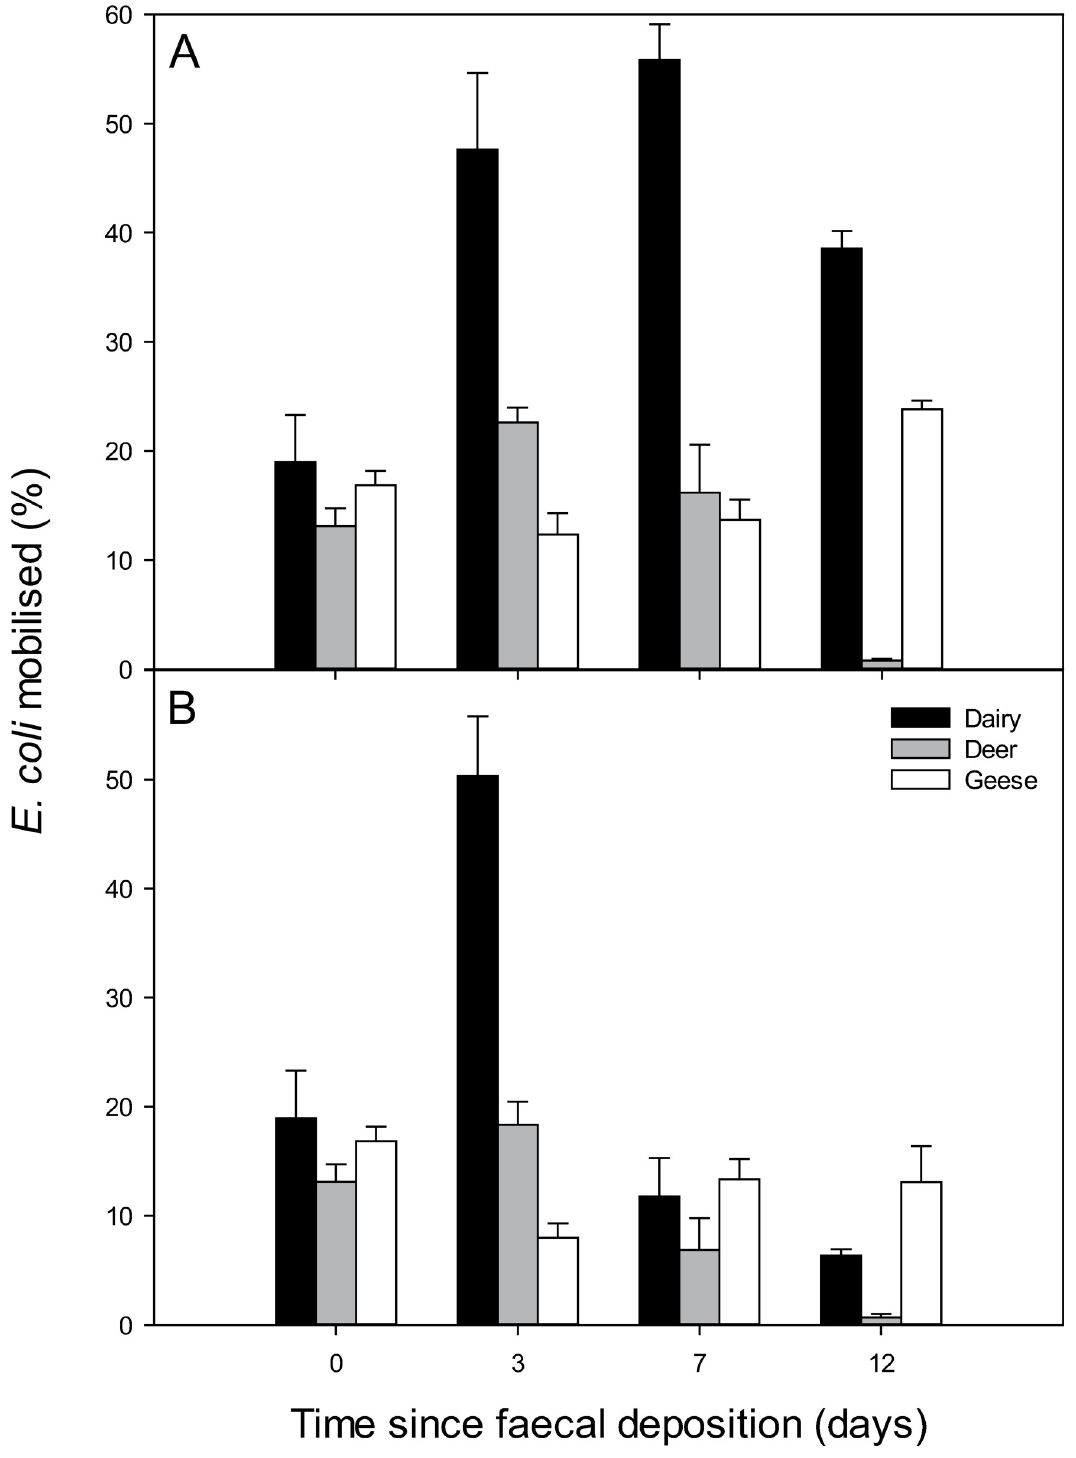
Fig 2. The proportion of E . coli mobilised from faeces over time. Faeces was stored under constant temperature conditions of A) 15˚C and B) 0˚C prior to each mobilisation assay. Data points are the mean of five experimental replicates ± standard error.